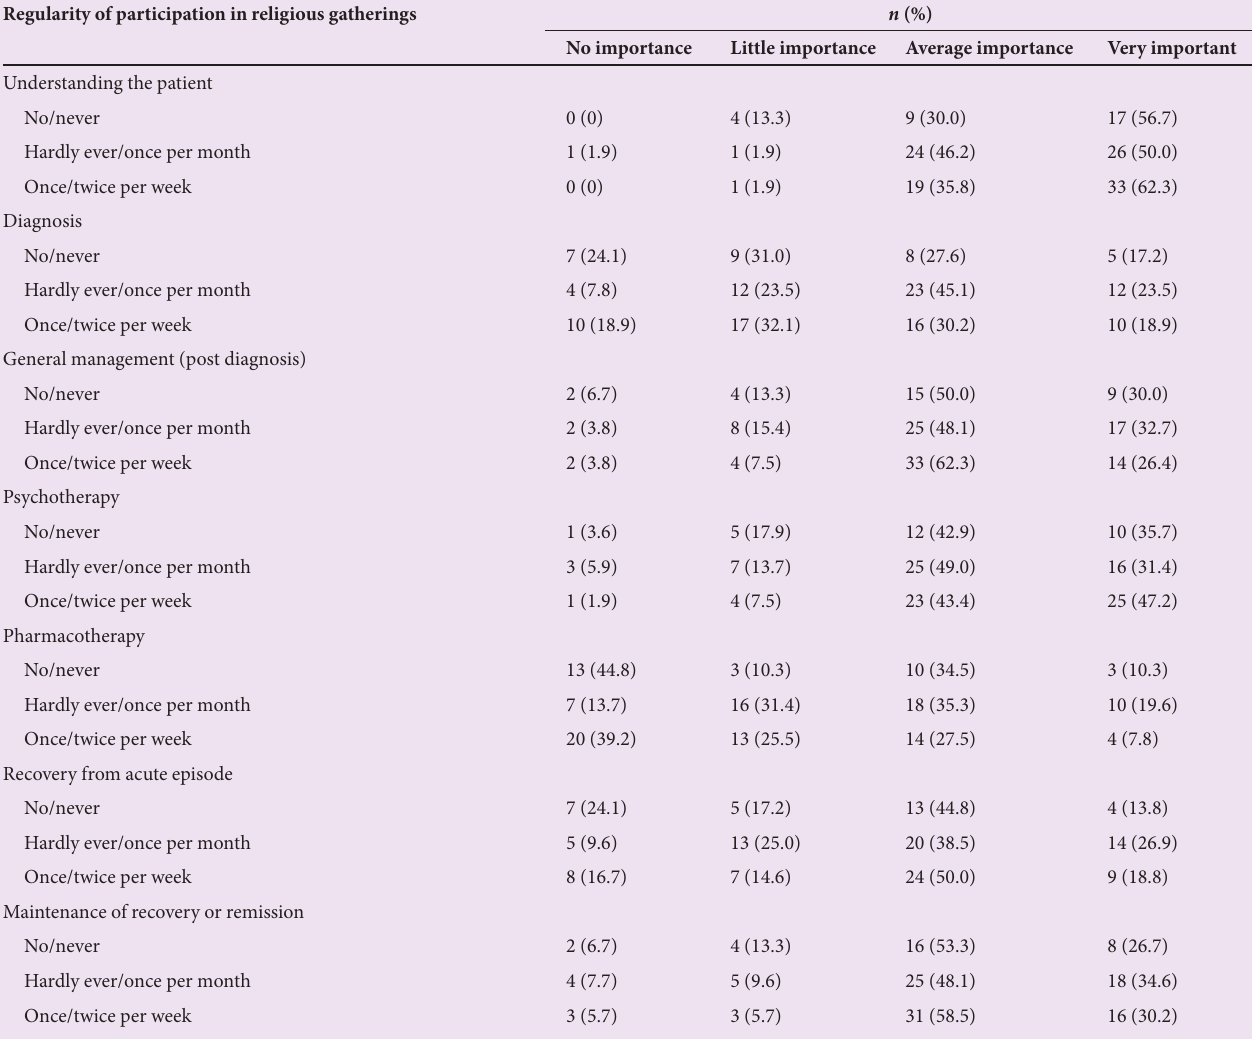
Table 3. Regularity of participation v. the importance ascribed to the patients’ religious beliefs Regularity of participation in religious